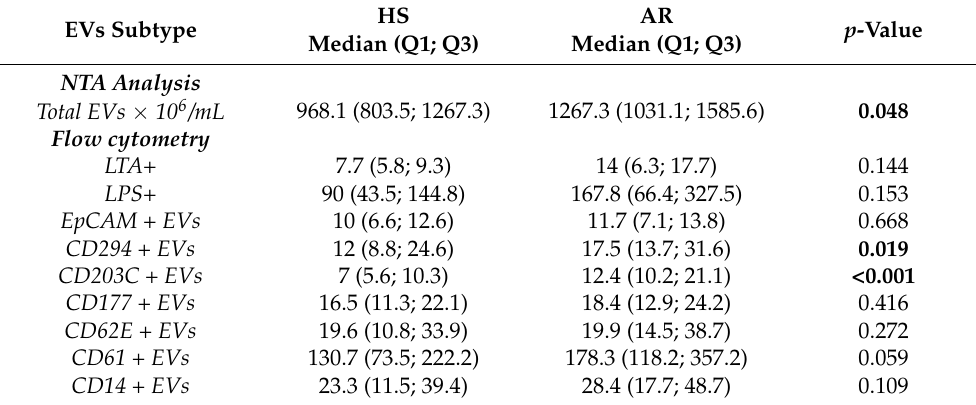
group (Table 2). The median concentrations of bEVs released from eosinophils (CD294 + EVs) and basophils (CD203C + EVs) were significantly increased in AR patients compared to the HS group. Table 2. NTA and CF analyses of EVs median concentrations of AR and HS groups.